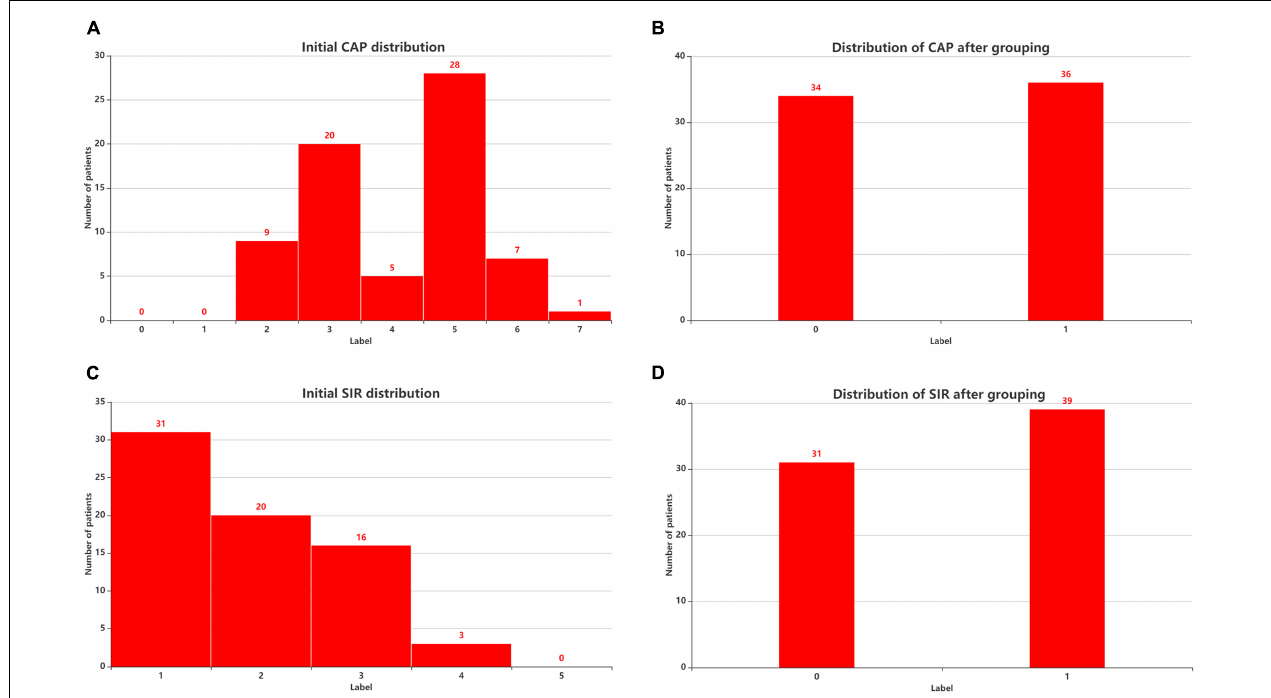
FIGURE 3 | Patient distribution before and after considering CAP and SIR grouping. (A) Initial CAP distribution. (B) Distribution of CAP after grouping. (C) Initial SIR distribution. (D) Distribution of SIR after grouping. CAP, categories of auditory performance; SIR, speech intelligibility